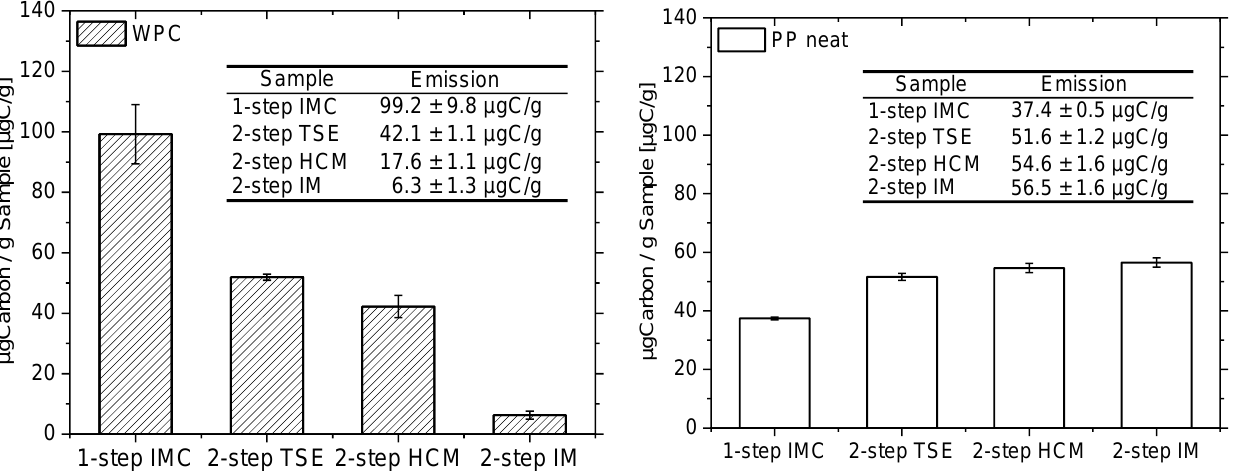
Figure 5. Resulting emissions in μgC/g for all processing methods analyzed; n = 9 for WPC ( left ), n = 3 for PP neat ( right ); 𝑋̅ ± 𝑆𝐷 , normal distribution confirmed by Shapiro – Wilk test.